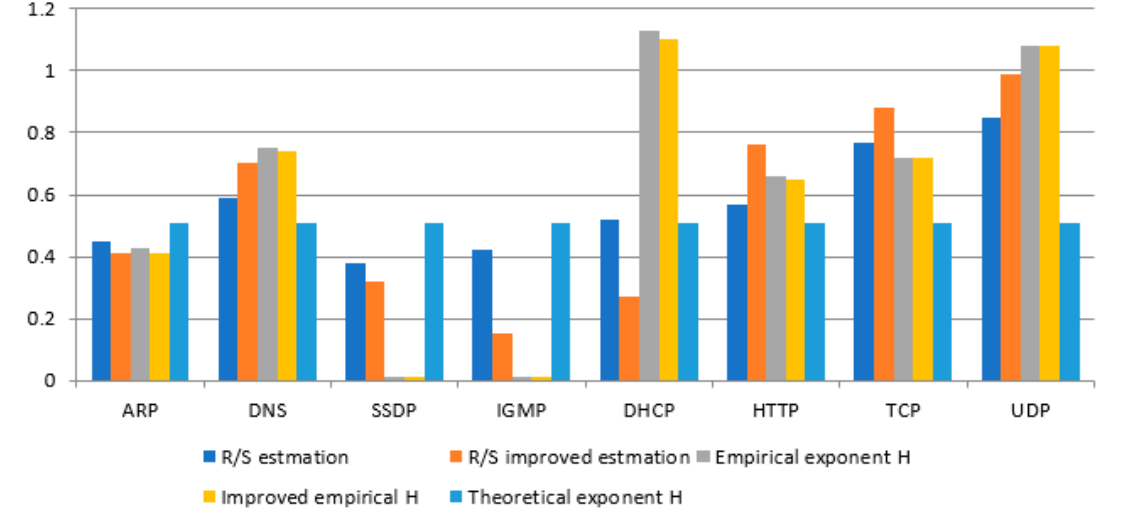
Figure 15. Detailed comparison of the value of the H exponent for the time window size 1024.